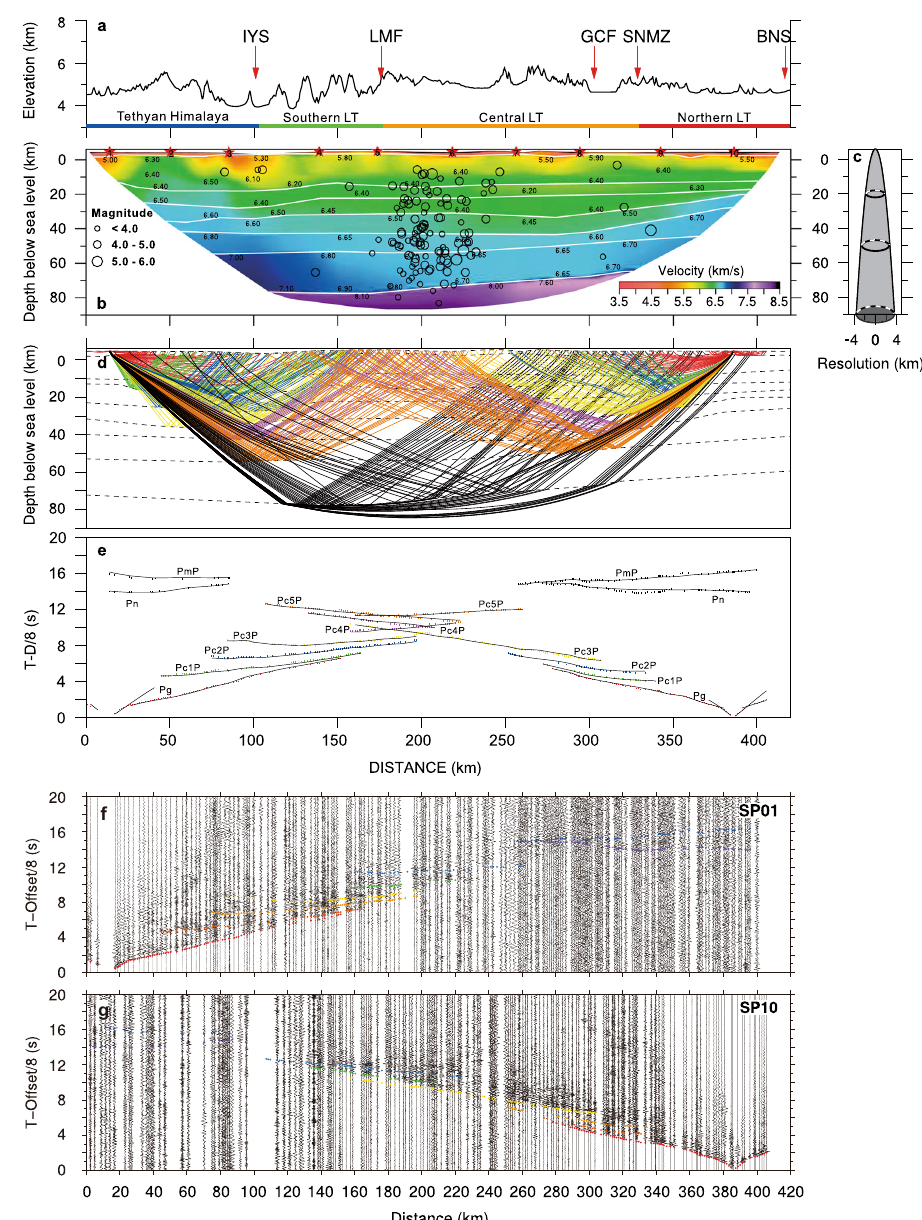
Fig. 2 Seismic P-wave velocity structure along our wide-angle seismic pro fi le across LT and TH. a Elevation of the seismic pro fi le with location of faults and suture zones (red arrows) and location of different terranes (color line). b Crustal velocity structure along the seismic pro fi le. Seismic sources: red stars; velocity discontinuities: white lines; location of earthquakes within a 100 km wide corridor: black circles; c Horizontal resolution for the velocity model estimated as the Fresnel zone width. d Ray tracing coverage of the seismic model for the end shots 01 and 10, illustrating the high resolution of the lower crust and depth to Moho, see also Supplementary Fig. 5. e Traveltime fi t for seismic phases for the two end shots. Lines show calculated traveltimes and vertical bars show observed traveltimes with length of bar corresponding to uncertainty of pick. f Seismic section for SP01 reduced by 8 km/s with traveltime picks. g Seismic section for the reversed SP10 with traveltime picks. Abbreviations as in Fig.